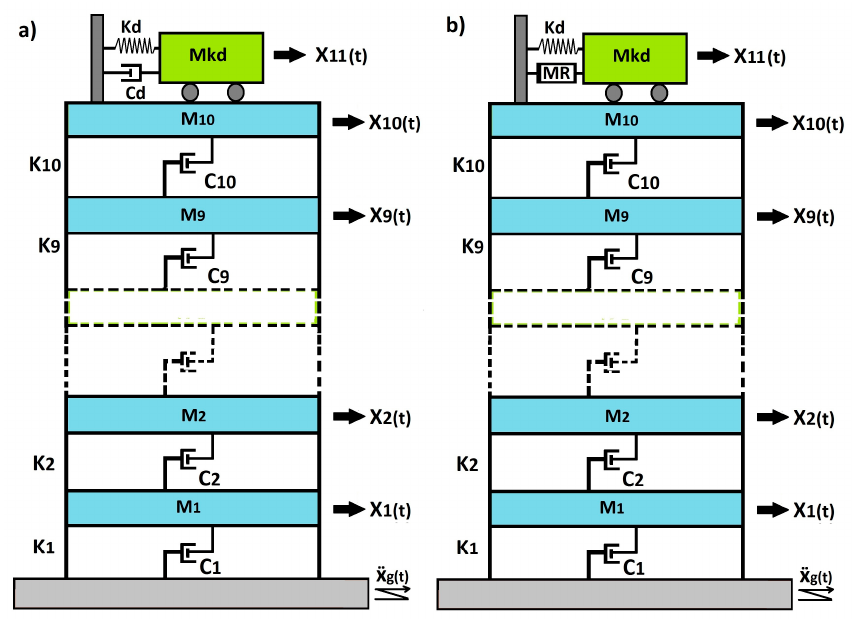
Figure 1. The two control cases. ( a ) Passive Control case, ( b ) Semi-active control case. Case A: Passive control of the tuned mass damper